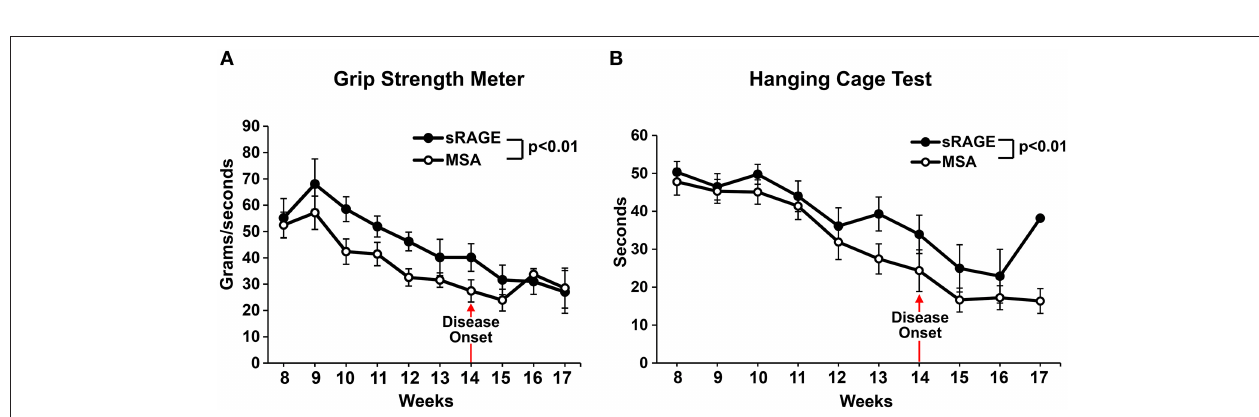
FIGURE 4 | sRAGE-treated transgenic SOD1 mice display improved motor function performance. Results of grip strength meter test (A) and hanging cage test (B) over time for both mice groups. All tests were performed in triplicate twice a week. As the number of mice able to perform the tests was significantly reduced after week 16 and 17, hence for consistency all results are shown only until week 17; n = 12 mice/group. Error bars represent SEM; disease onset is indicated by an arrow.